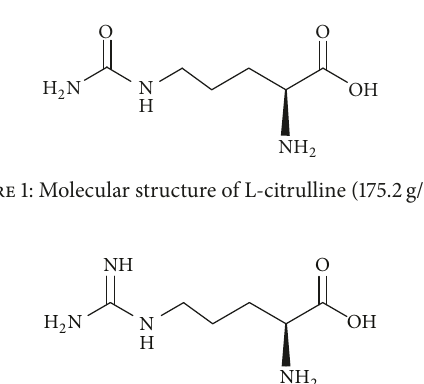
Figure 2: Molecular structure of L-arginine (174.2